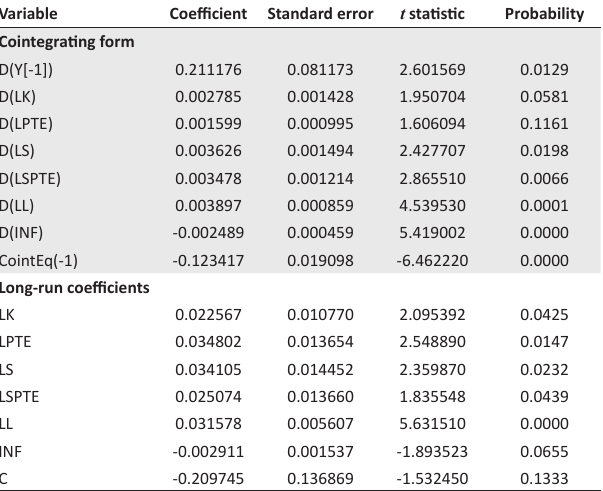
TABLE 9: Autoregressive distribution lag short- and long-run results for Buffalo. Variable